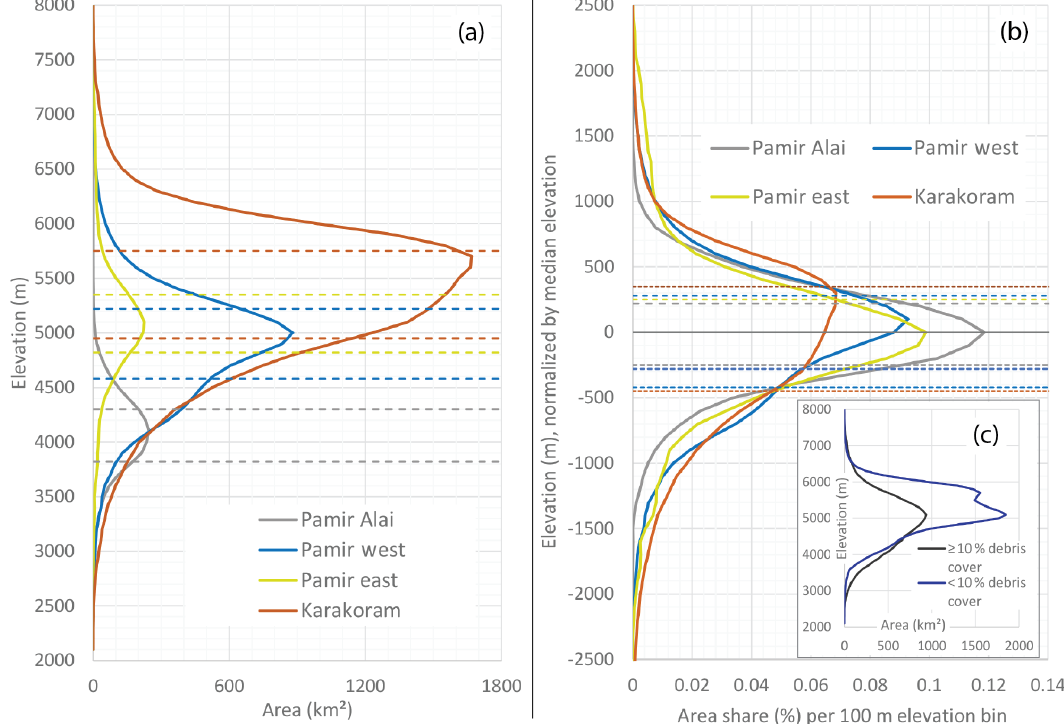
Figure 12. Glacier hypsography of the different regions (a) , normalized by the respective median elevation (b) . Dashed lines represent the